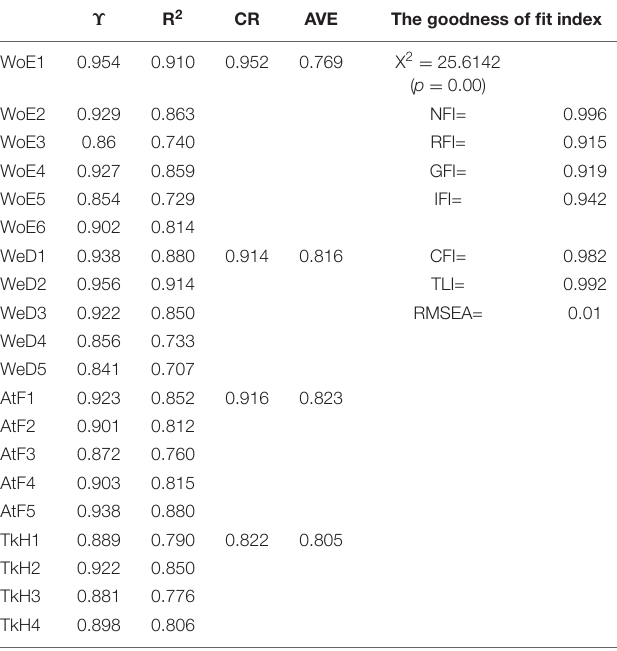
TABLE 8 | Results of measurement model estimation.